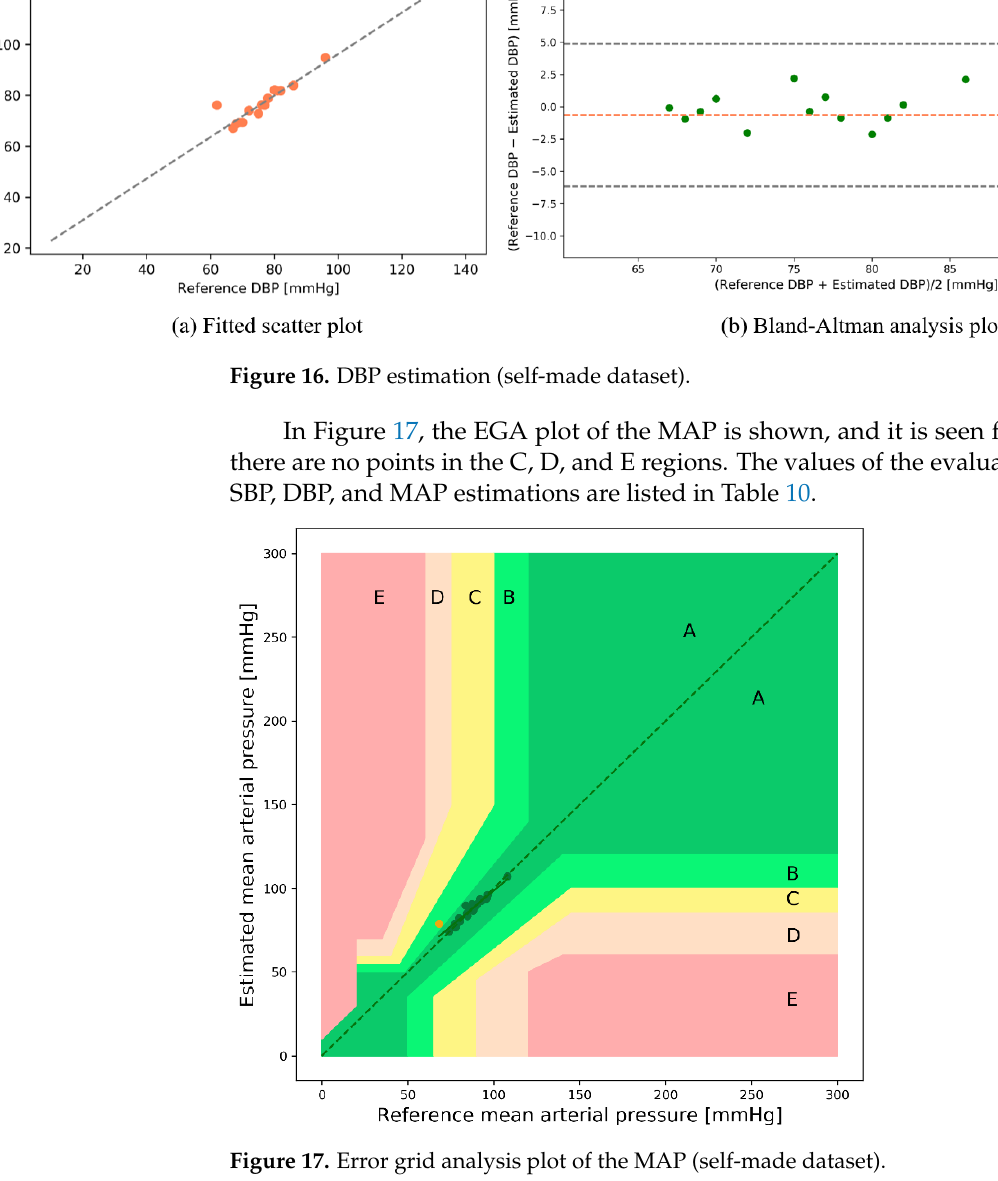
Figure 15. SBP estimation (self-made dataset).